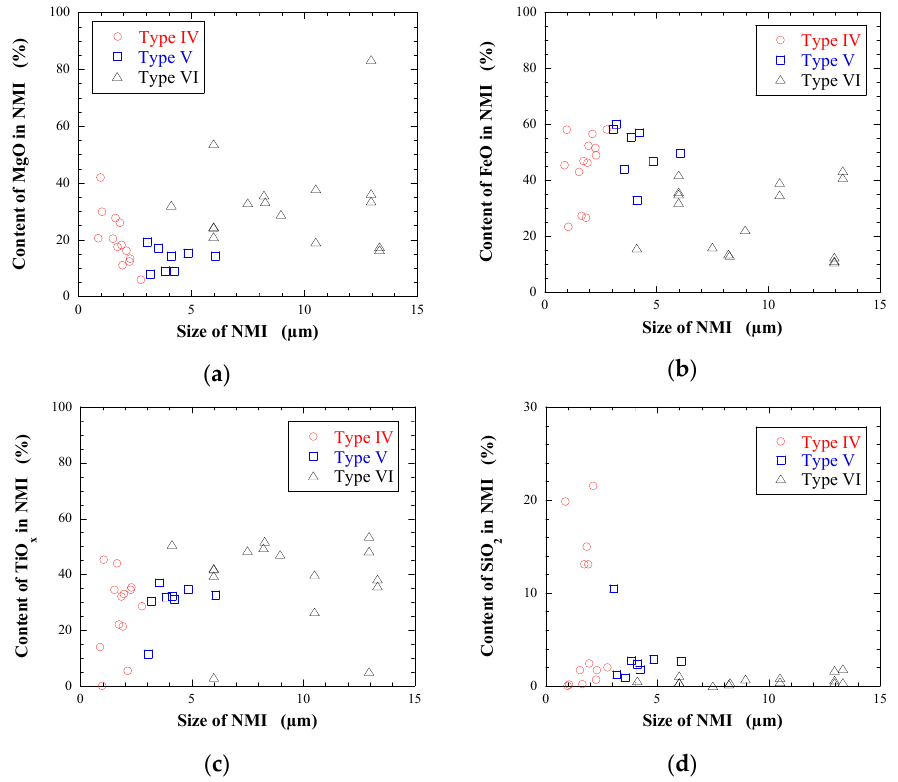
Figure 6. Contents of MgO ( a ), FeO ( b ), TiO x ( c ) and SiO 2 ( d ) in different inclusion types observed after electrolytic extraction of the Ti/Mg-5 sample.